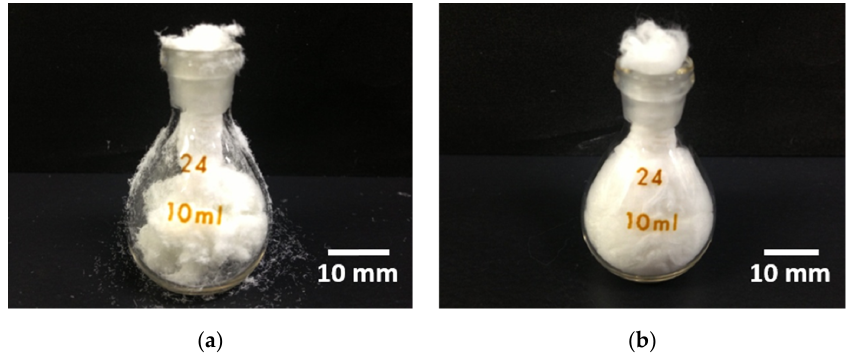
Figure 4. Entire views after cramming 500 g of cotton ‐ wool ‐ like materials into a glass bottle (specific gravity bottle) of 10 mL: ( a ) SiVPC; ( b ) PLGA ‐ coated SiVPC.